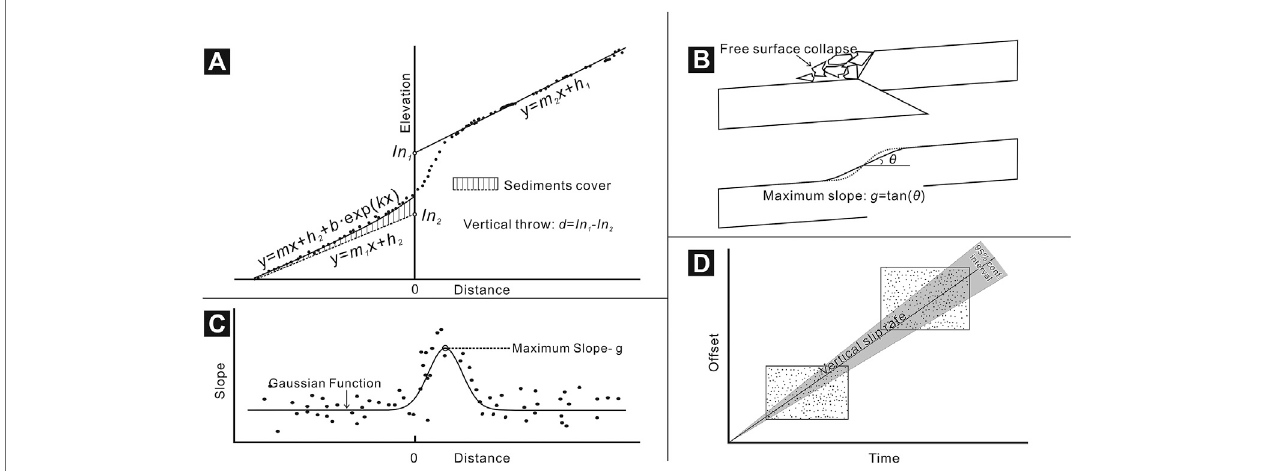
FIGURE 2 | Illustration of determining the vertical throw, maximum slope of scarp and vertical slip rate. (A) We assume the hangingwall and footwall (linear term) have the same nature slope. The footwall is buried with sediments whose thickness decrease exponentially from the fault (exponential term) (e.g., Champagnac et al., 2010). (B) Faultingeventfollowsagravity-drivencollapseafterwhichthescarpundergoesaslowerdegradationphasedominatedbyraindropimpactandsoilcreep. (C) Gaussian fi tting reveals the maximum slope on the scarp. (D) 1,000 times of Monte Carlo simulation displacement-time (d – t) vectors are projected on a d-t plane, then the slope of the linear regression reveals the vertical slip